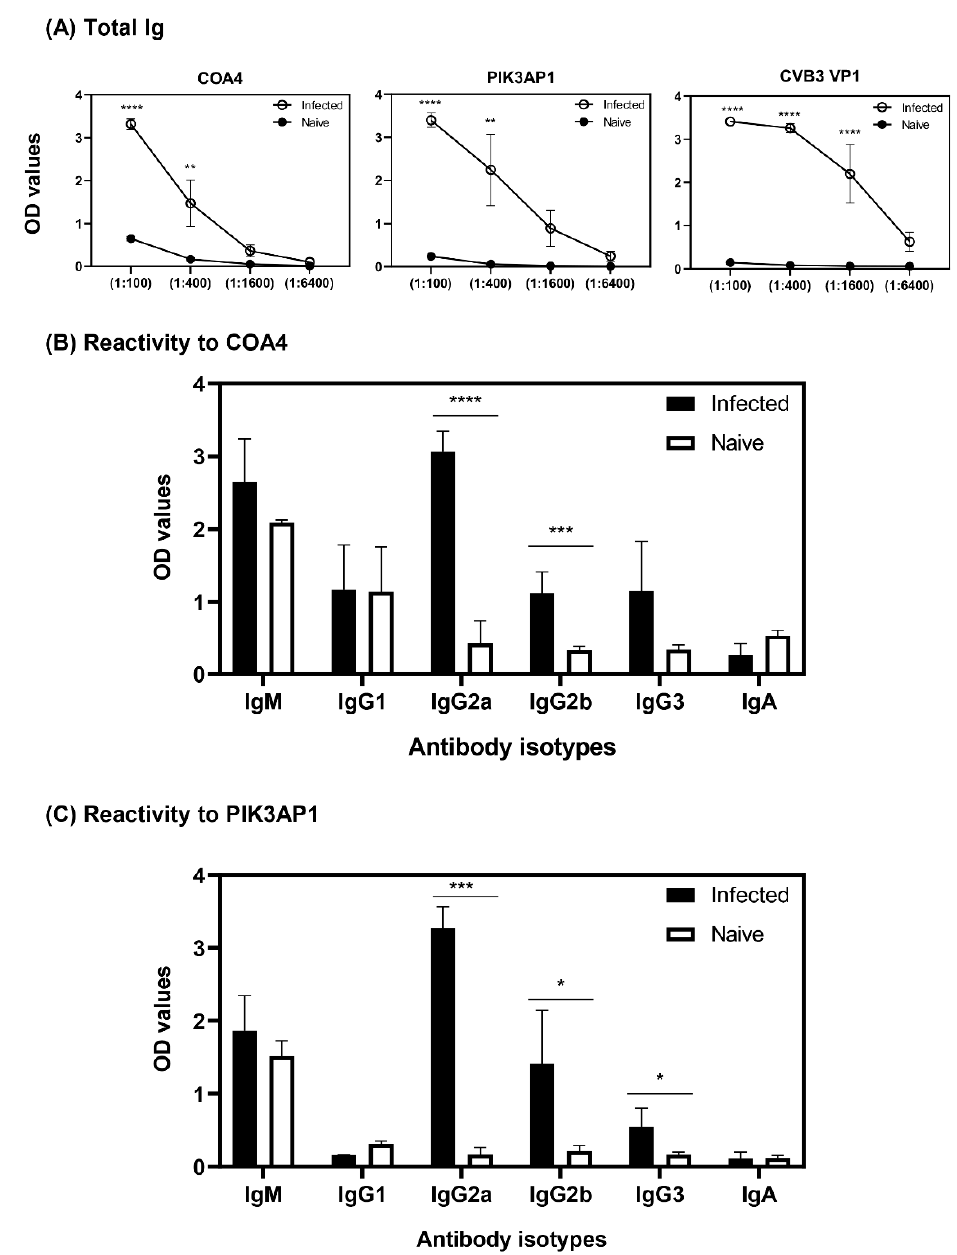
Figure 5. Sera from CVB4-infected animals revealed autoantibodies to COA4 and PIK3AP1 similar to CVB3 infection. ( A ) Total Ig. A/J mice were infected with or without CVB4, and sera collected at termination on day 21 post-infection were serially diluted and added in duplicates to plates coated with COA4, PIK3AP1, or CVB3 VP1. After washing and addition of HRP-conjugated anti-mouse total immunoglobulin and substrate, reactions were stopped, and the OD values were measured at 450 nm. ( B ) and ( C ) Reactivity to COA4 and PIK3AP1. The serum samples described above were evaluated for their reactivity to the indicated proteins. Diluted serum samples (1:100) were first added, followed by HRP-conjugated anti-mouse IgM, IgG1, IgG2a, IgG2b, IgG3, and IgA as detection antibodies. After adding substrate, reactions were stopped to measure the OD values. Mean ± SEM values for infected ( n = 4) and naïve groups ( n = 3), each representing the pool of sera from 3 to 4 mice, are shown. Two-way ANOVA with Sidak’s test was used to determine significance between groups. * p ≤ 0.05, ** p ≤ 0.01, *** p ≤ 0.001, and **** p ≤